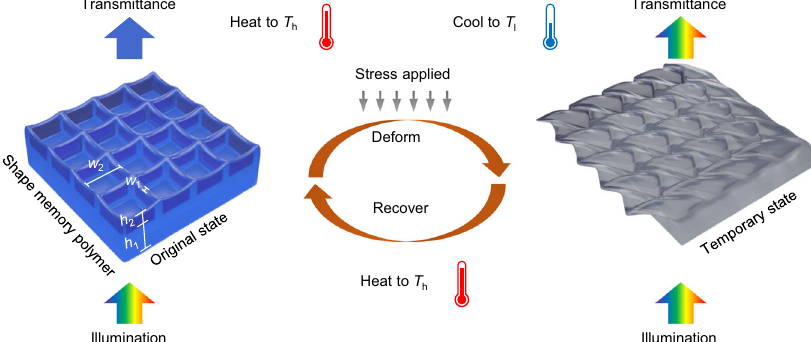
Fig. 1 Schematic of colour and shape change of a constituent nanostructured element of the “ invisible ink ” 3D printed in shape memory polymer (SMP). The as-printed structures with upright grids (left) function as a structural colour fi lter that transmits only a limited wavelength range of visible light. Deformation of the structures at elevated temperature fl attens the nanostructures (right) rendering it colourless, where it remains in an invisible state after cooling to room temperature. Heating recovers both the original geometry and colour of nanostructures, leading to a submicron demonstration of 4D